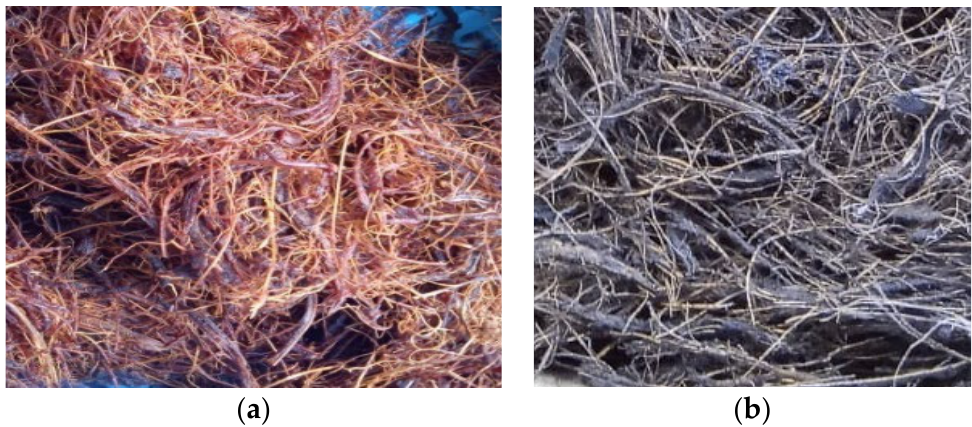
Figure 1. ( a ) Appearance of fibers during NaOH treatment, and ( b ) silica-fume treatment. A sample of uncut fibers was collected and subjected to the treatments described above. Another part was left untreated (50 specimens by typology). These were labeled, and their weight and length were taken. They were tested at the Polytechnic Textile Center from the National Polytechnic School (EPN). An Instron 3345 tensile testing equipment was used, following the guidelines of the ASTM D2256 standard [27]. The specimens were located in the apparatus and tensile loads at a crosshead speed of 30 mm/minute were applied until break. Breaking force (N) and elongation (mm/mm) were measured using